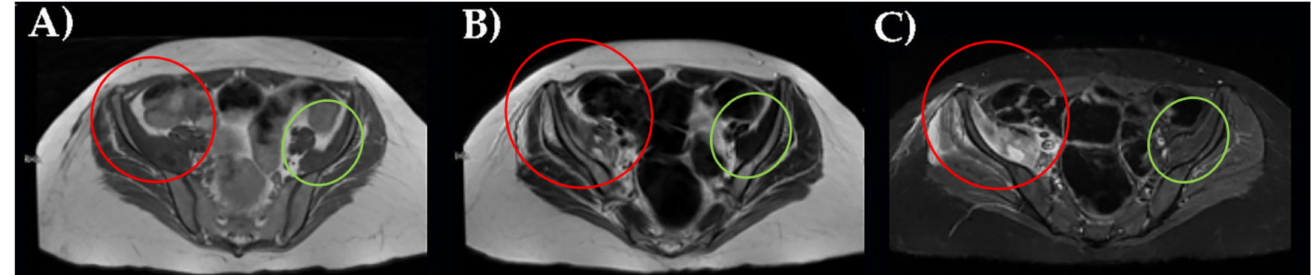
Figure 2. MRI of the pelvis with right ileal muscle hematoma performed with a T1- ( A ), T2- ( B ), and STIR sequences ( C ). In red, pathological finding; in green, normal